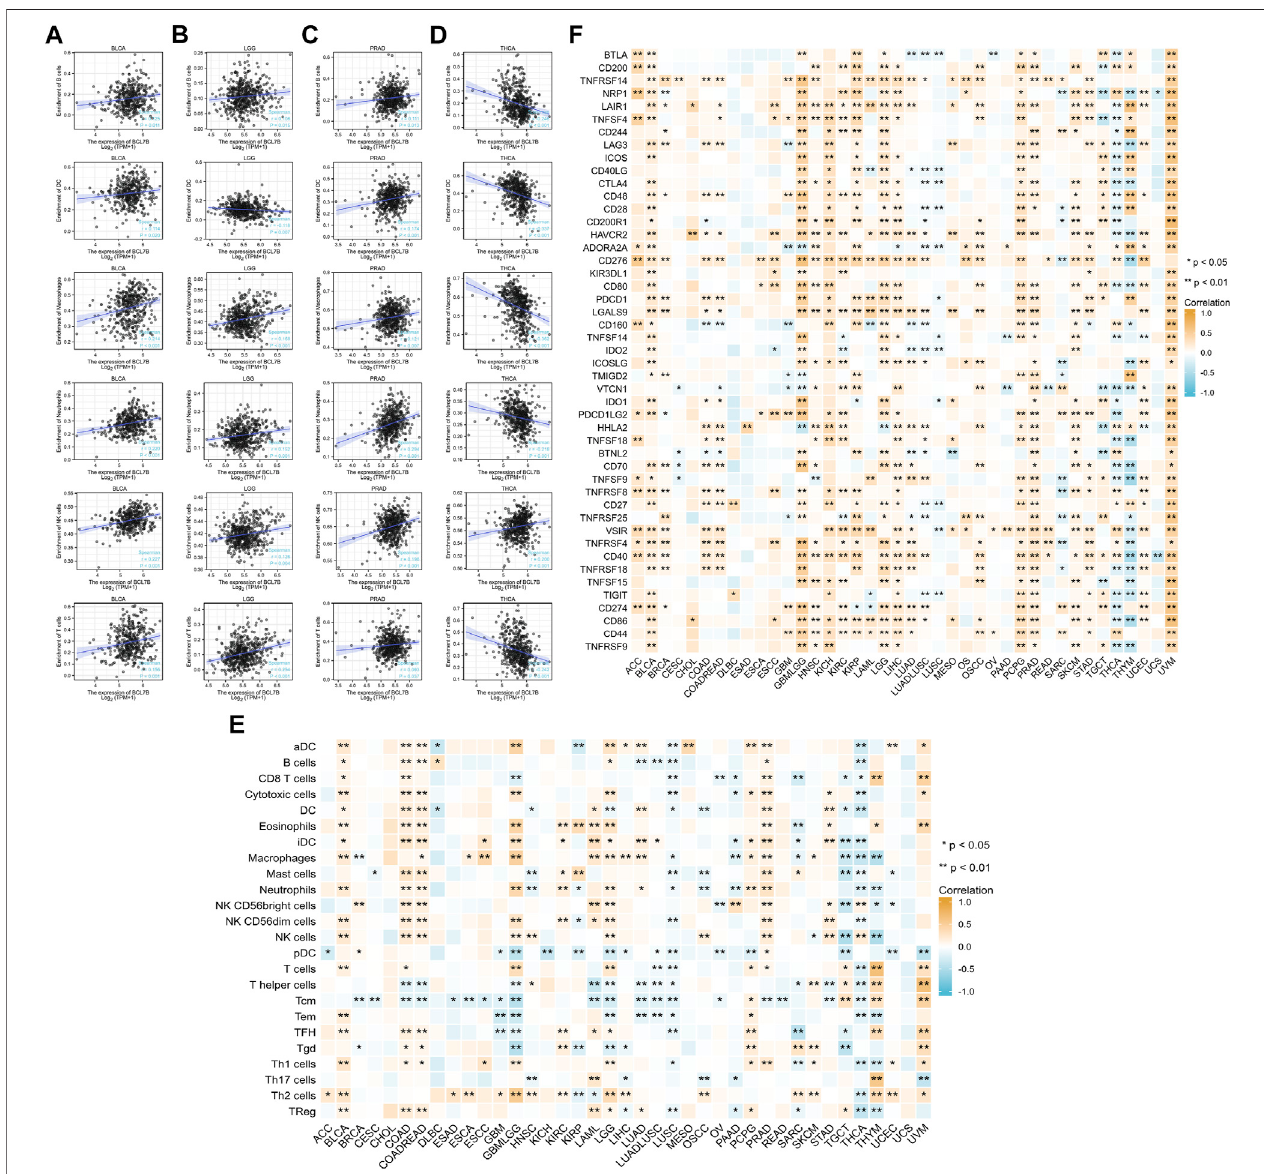
FIGURE 3 | Correlation analysis of BCL7B gene expression in immune cell in fi ltration and 47 immune checkpoints. (A – D) In 39 types of tumors, only BLCA, LGG, PRAD, and THCA had correlation with all six immune cells including B cells, dendritic cells, neutrophils, T cells, macrophages, and NK cells (E) Correlation between BCL7B gene expression and in fi ltration of 24 immune cells in 39 types of tumors. (F) Relationship between BCL7B gene expression and 47 immune checkpoints in 39 types of tumors. p p < 0.05 and pp p < 0.01.